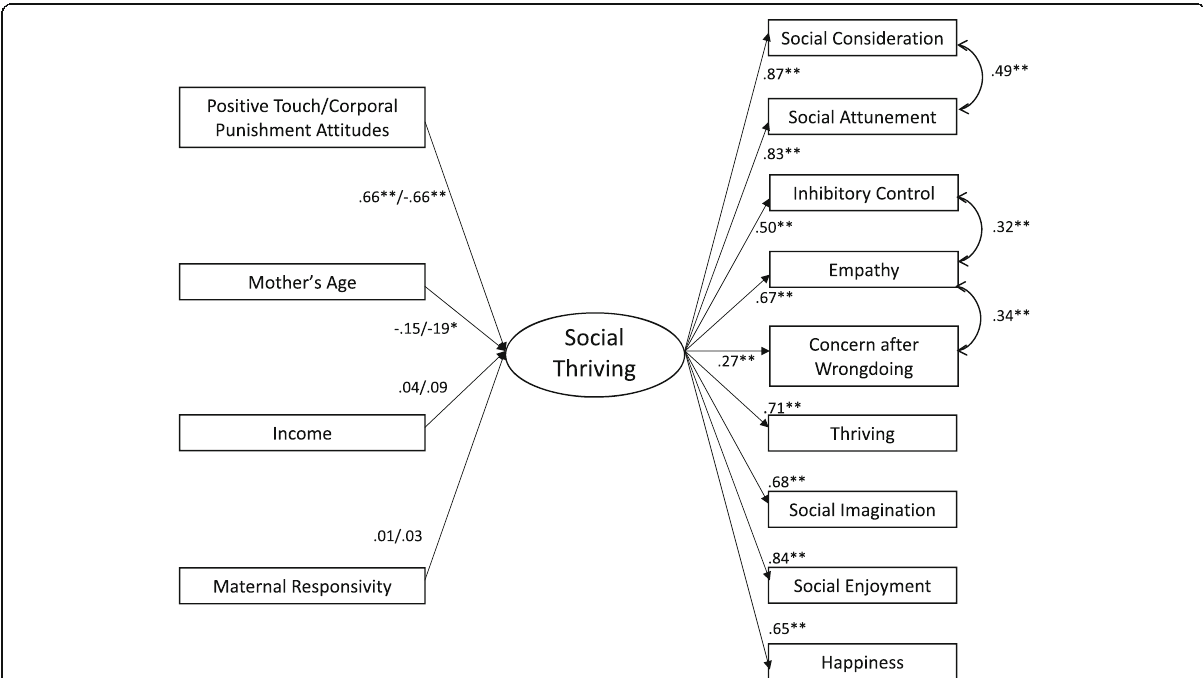
Fig. 1 Social thriving predicted by touch attitudes, separate models. All coefficients are standardized. Coefficients for positive touch and corporal punishment attitudes are separated by “ / ” for all predictors. Latent variable loadings and covariances are constrained in both models and are the same for both models. Positive touch attitudes predicting social thriving fit indices: robust χ 2 (67) = 94.599, p = .015; robust CFI = .963; RMSEA = .051, 90% CI = [.025, .073]; SRMR = .054. Corporal punishment attitudes predicting social thriving fit indices: robust χ 2 (67) = 145.120, p < .001; robust CFI = .902; RMSEA = .086, 90% CI = [.068, .105]; SRMR =